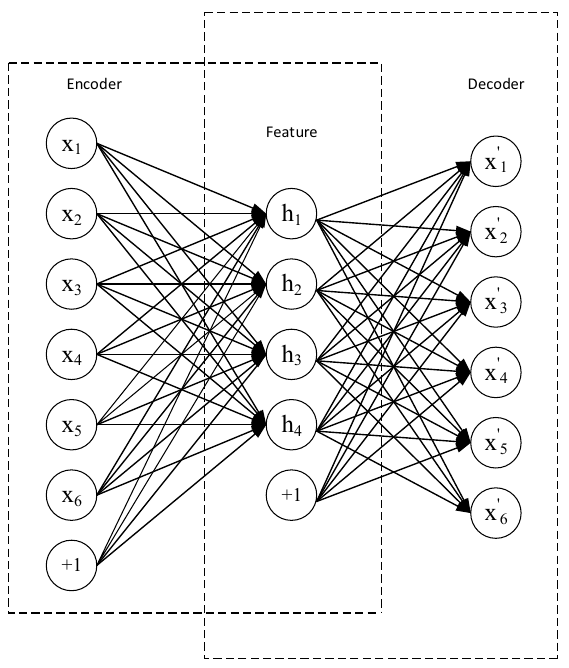
Figure 1. The structure of a basic autoencoder.